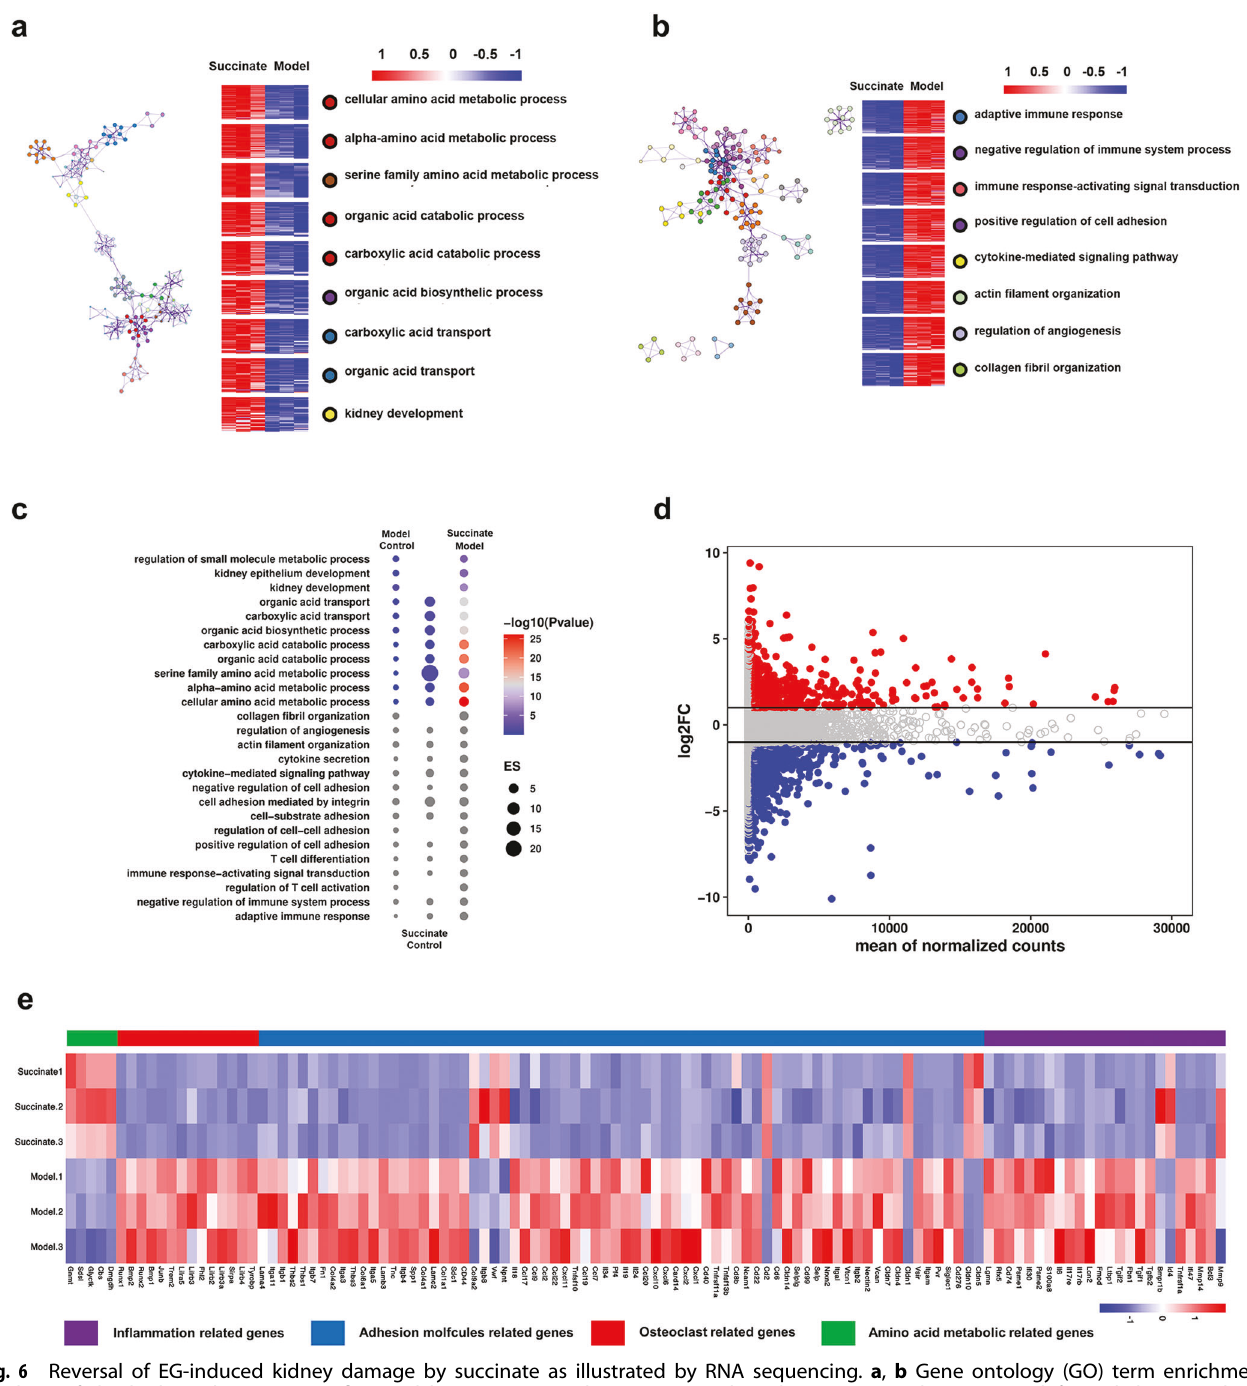
Fig. 6 Reversal of EG-induced kidney damage by succinate as illustrated by RNA sequencing. a , b Gene ontology (GO) term enrichment analysis of the biological processes in fl uenced by succinate and EG-treatment based on RNA-seq dataset. Up- (left) and downregulated processes (right) in the succinate treated group as compared with EG-treated model group. c Dot plot showing pairwise GSEA pathway comparison of the RNA-seq dataset of the succinate- and EG-treated model group and the corresponding controls. Blue and red dots respectively represented the down- and upregulated pathways. d A scatter plot showing expression fold change of DEGs between EG-treated model group and succinate group based on the RNA-seq dataset. e Heatmaps showing the expression of genes associated with in fl ammatory, apoptotic, and survival events in the rat kidney tissues from the EG-treated and succinate treated groups based on RNA-seq analysis. For ( a – e ), n = 3 rats in each group EG-treated model, which exerted a protective effect on the kidney were signi fi cantly enriched for amino acid metabolism (Fig. 6a, c, injury. By RNA-seq analysis, the EG-treated group showed similar Supplementary Fig. 7), while those in the succinate group were enrichment for pathways including pro-in fl ammatory, adhesion signi fi cantly enriched for immune response and cell-cell adhesion molecules and osteoclast differentiation cell, etc. in the model molecules (Fig. 6b, c, Supplementary Fig. 7) compared with the